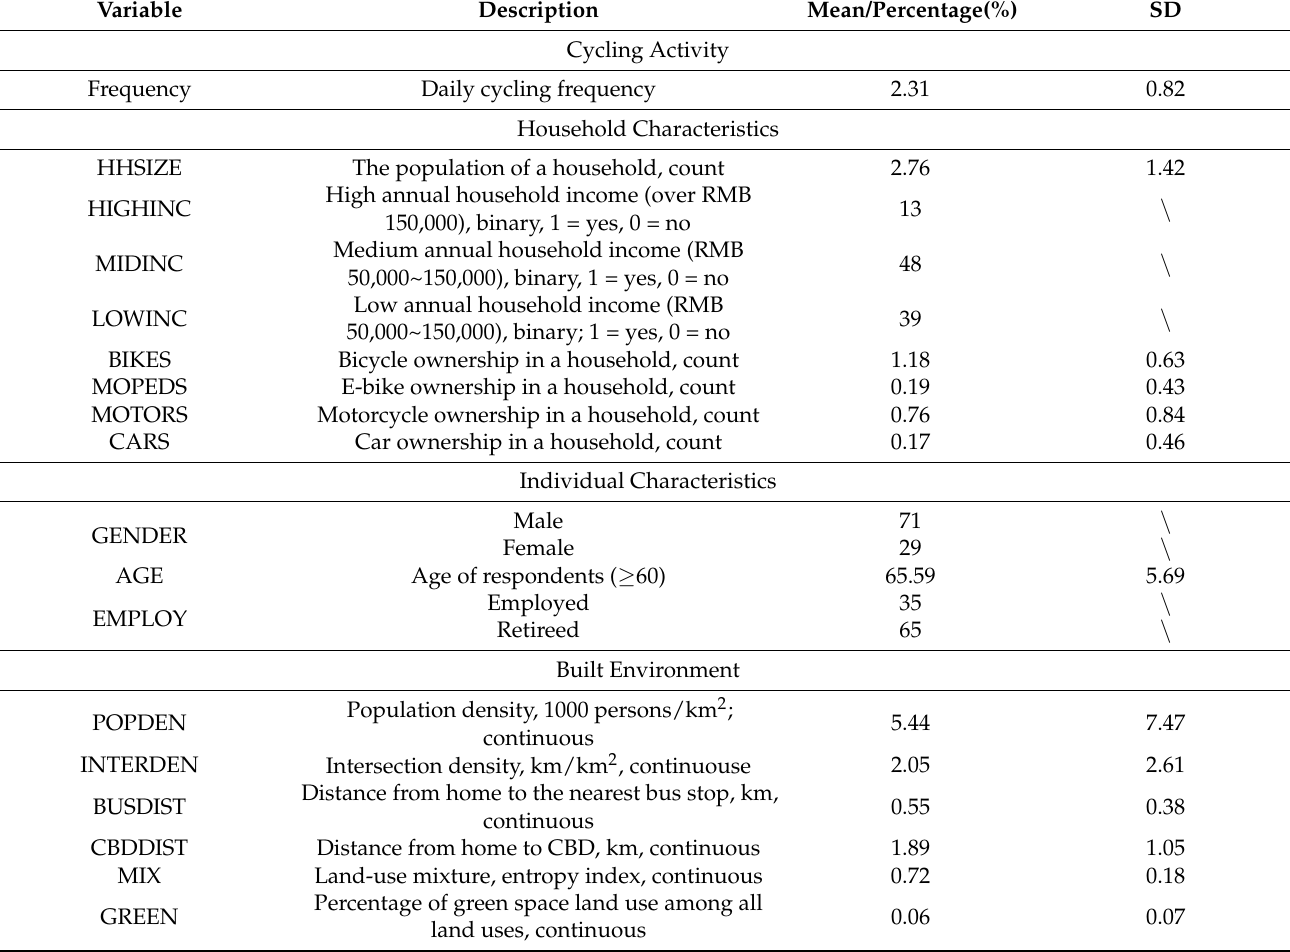
Table 3. The description of variables used in the